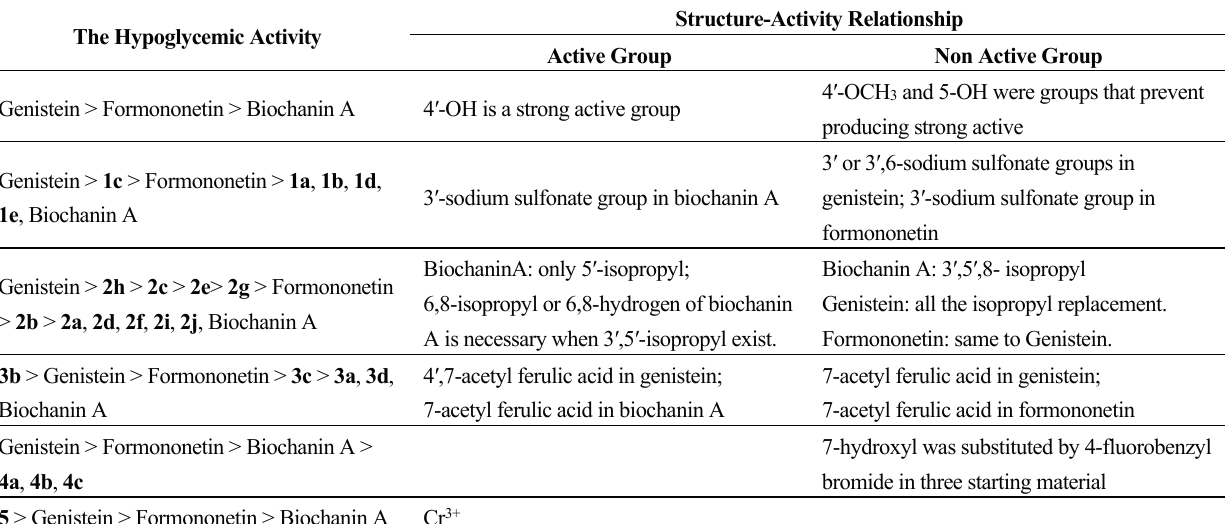
Table 1. Structure-activity relationship analysis.